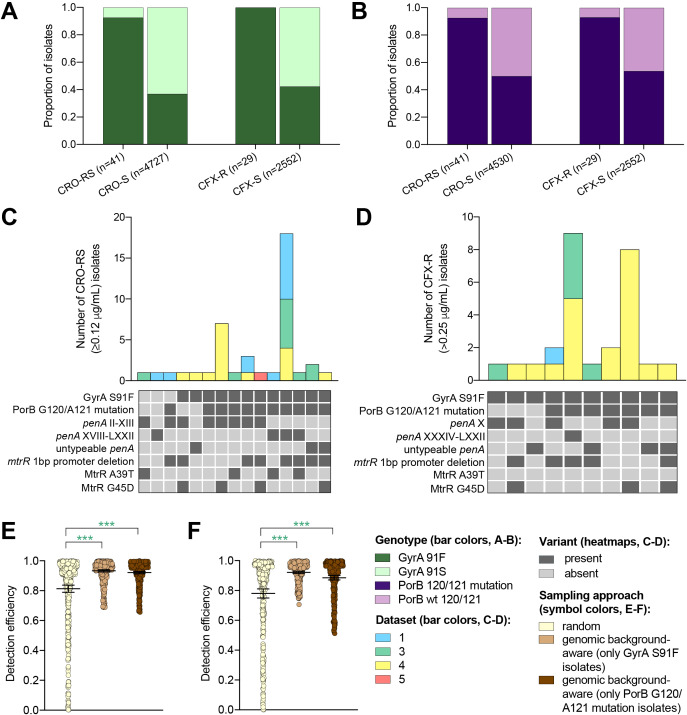
The impact of genomic background-aware sampling on the detection efficiency of phenotypic resistance variants.Bar charts showing the proportions of ceftriaxone reduced susceptibility (CRO-RS) isolates, ceftriaxone susceptible (CRO-S) isolates, cefixime resistant (CFX-R) isolates, and cefixime susceptible (CFX-S) isolates with GyrA S91F and GyrA S91 wild-type alleles (A) and with PorB G120 and/or A121 mutations and PorB G120 and A121 wild-type alleles (B) across datasets 1–5. Bar charts showing the number of (C) CRO-RS and (D) CFX-R isolates with each haplotype, along with heatmaps showing the presence or absence of the GyrA S19F mutation, the PorB G120 and/or A121 mutations, and other alleles at loci previously associated with extended spectrum cephalosporin resistance. Bar colors in (C) and (D) indicate the dataset from which the isolates were derived. Scatter dot plots showing the detection efficiency (with lines indicating the mean and 95% confidence intervals from 100 simulations) for CRO-RS (E) and CFX-R (F) in all datasets in which the variant was present. Dot colors in E–F) indicate the sampling approach, and asterisks indicate a significant difference (p<0.05 by Mann-Whitney U test) in detection efficiency between the phylogeny-aware approach compared to random sampling (*p<0.05, **p<0.01, ***p<0.001; green asterisks indicate significantly higher detection efficiency of the genomic background-aware approach compared to random sampling).